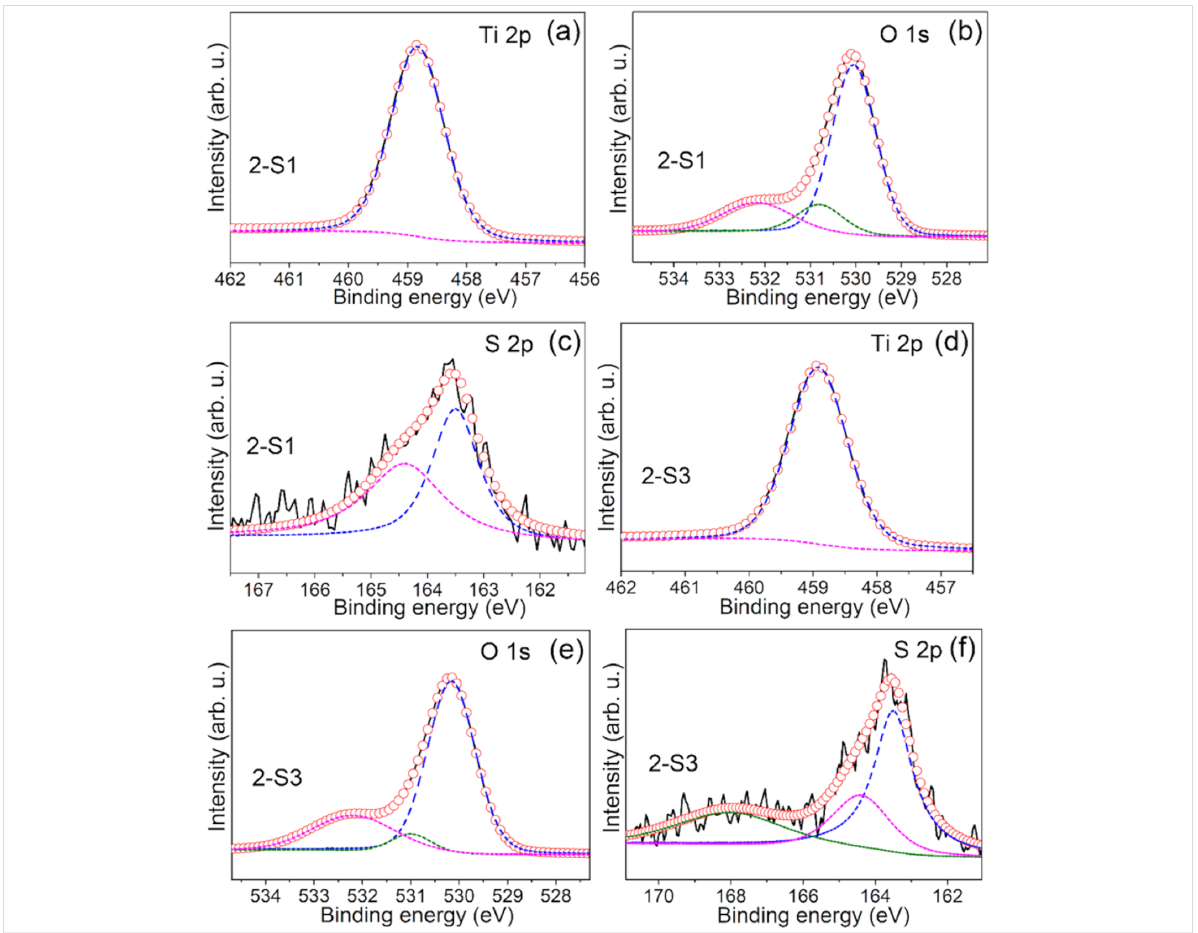
Figure 4: Core-level XP spectra of Ti 2p (a and d), O 1s (b and e) and S 2p (c and f) for 2-S1 and 2-S3. The solid line is the experimental curve, the dashed line is the fitted curve, and the open circles are the sum of the fitted curves.